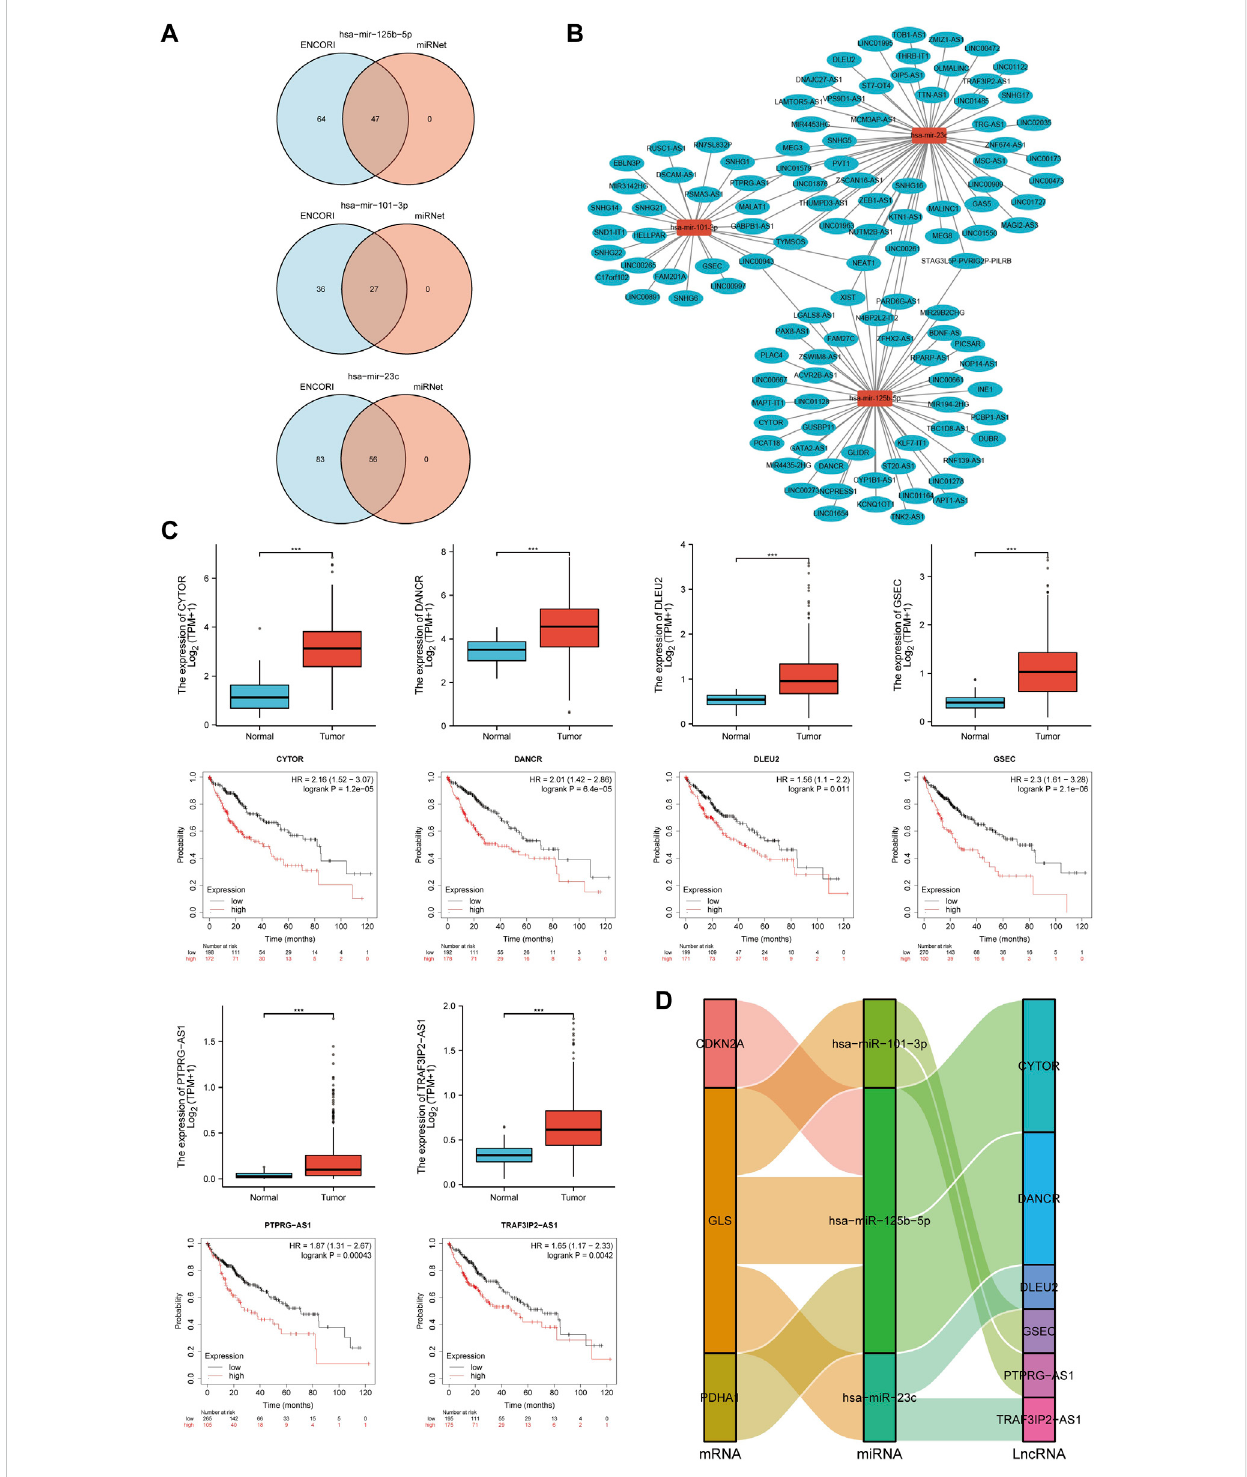
FIGURE 15 Screening of the regulatory axis of lncRNA-miRNA-CRGs in HCC. (A) Potential lncRNAs associated with hsa-miR-125b-5p, hsa-miR-101-3p and hsa-miR-23c predicted by miRNet and ENCORI databases. (B) Potential miRNA-lncRNA network constructed using Cytoscape software. (C) Expression and prognostic value of six potential lncRNAs in HCC. (D) lncRNA-miRNA-mRNA triple regulatory network affecting the prognosis of